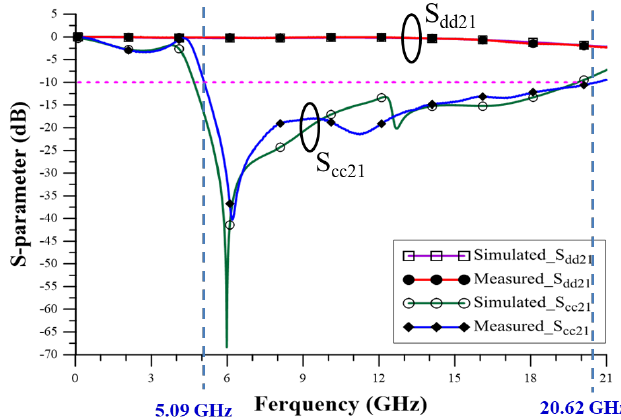
Figure 8. Comparison of simulated and measured insertion loss results.